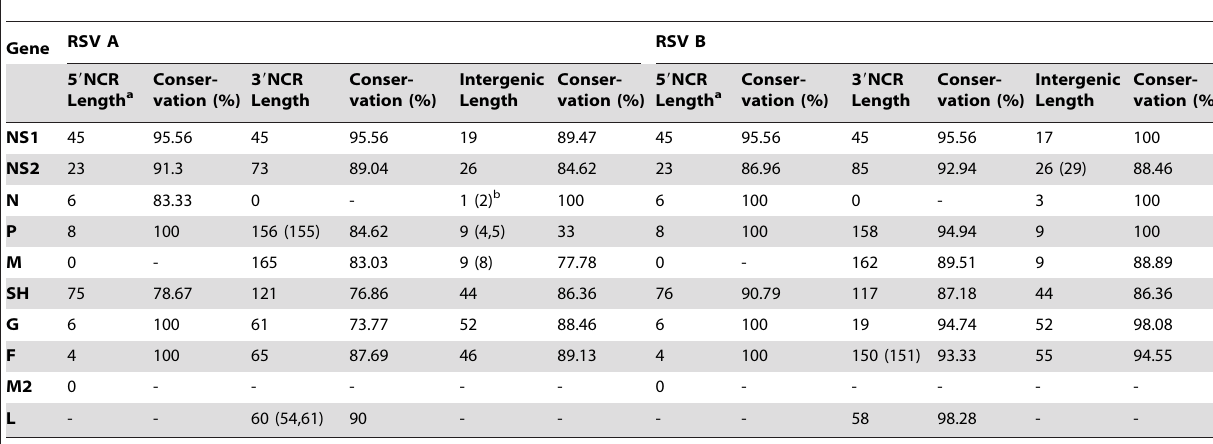
Table 3. Lengths and conservation of the NCR and IGS regions in RSV A and B.